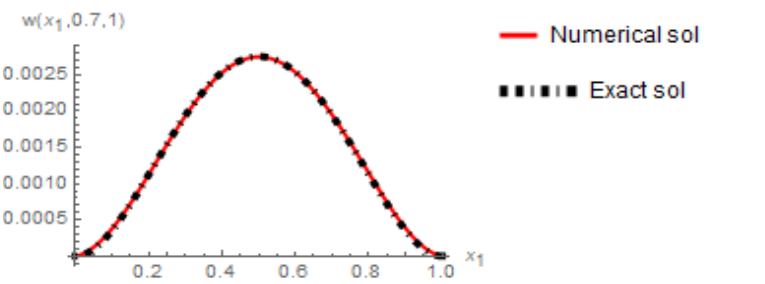
Figure 2. Comparison the exact and numerical solution of (21) at t = T = 1, x 2 = 0.7, τ = 0.05, h = 0.1, β = 0.6, α = 0.7 for different α